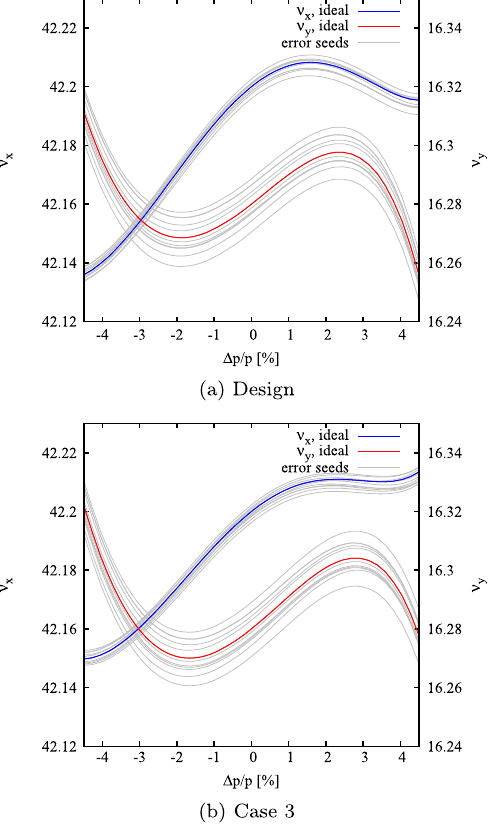
FIG. 15. Chromatic tune shifts for the design lattice and the Case 3 SCVDB lattice, adjusted for E errors. Ideal lattice in blue (horizontal) and red (vertical). Ten error seeds in